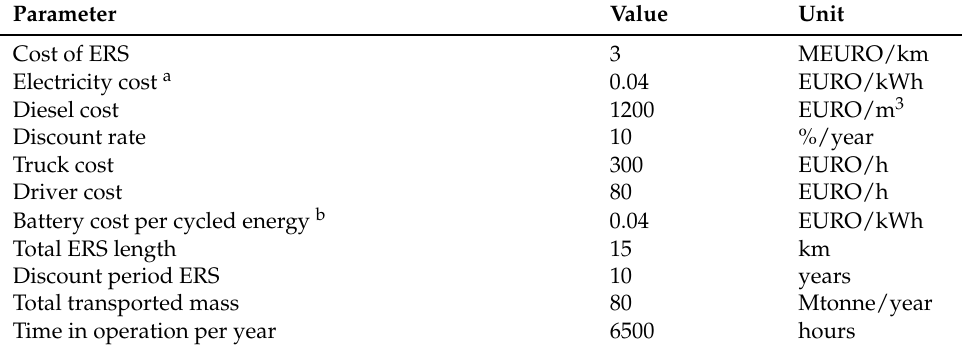
Table 7. Economic assumptions, roughly based on the Aitik